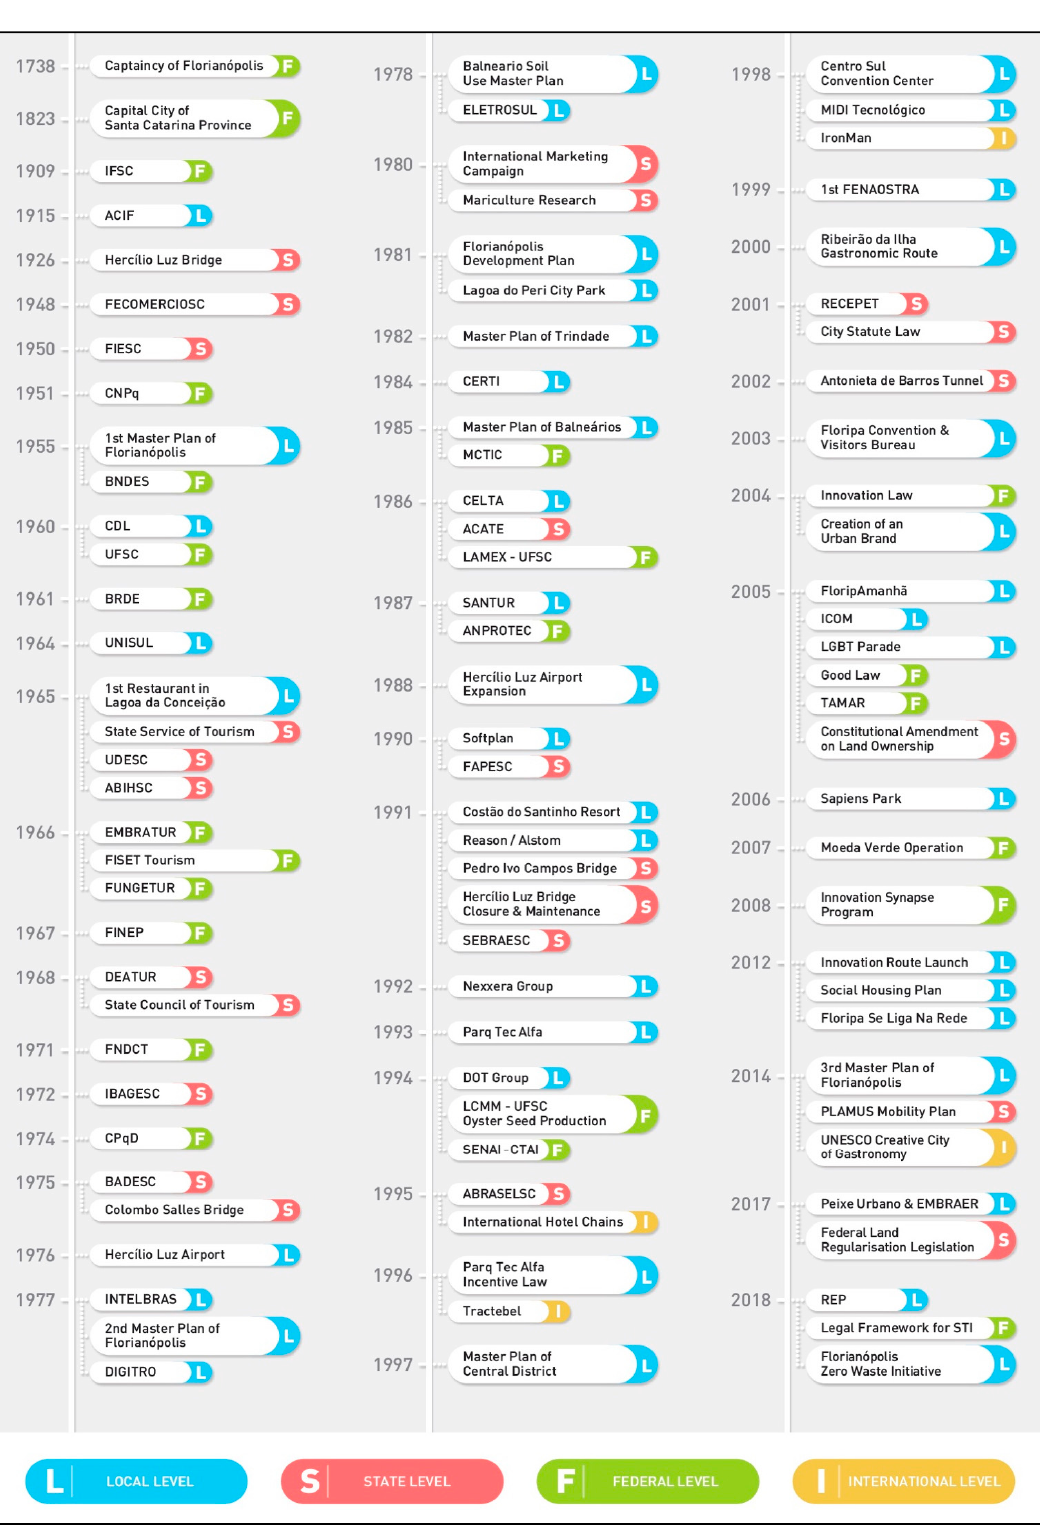
Figure B1. Timeline of Florianopolis’ developmental milestones, authors’ own compilation. Figure A1. Timeline of Florianopolis’ developmental milestones, authors’ own